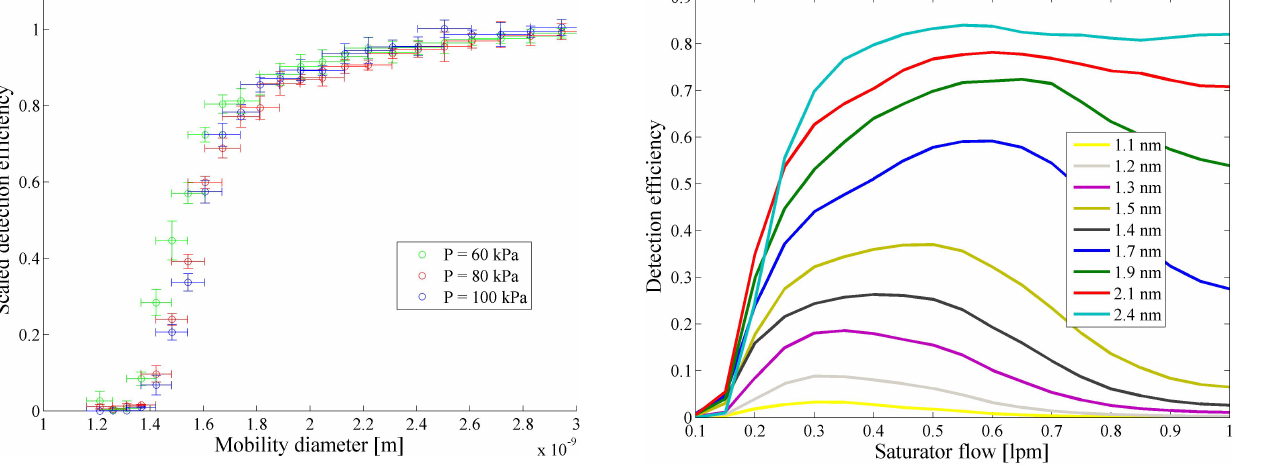
Figure 7. The detection efficiency of the nCNC for negatively charged particles formed during heating of ammonium sulfate, when the PSM was operated in mixing activation mode.